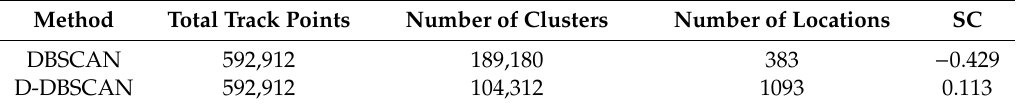
Table 3. Location extraction results of di ff erent clustering algorithms. SC, silhouette coe ffi cient.